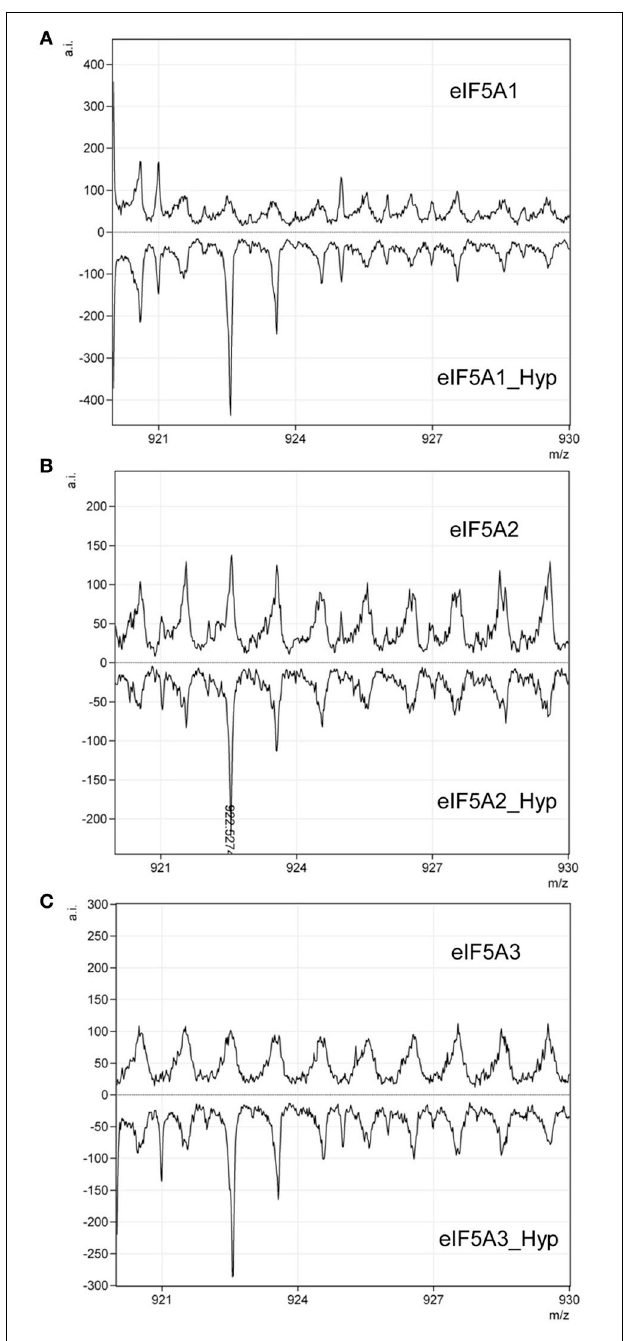
FIGURE 3 | Qualitative assessment of eIF5A hypusination by MALDI-TOF. Recombinant eIF5A proteins modified by hypusination or unmodified: eIF5A1 (A) , eIF5A2 (B) , and eIF5A3 (C) , were subjected to trypsin digestion and checked by MALDI-TOF for the presence or absence of a tryptic peptide of m/z 922.5. Only hypusine-modified proteins showed the presence of the peptide of the expected m/z as indicated in (B)